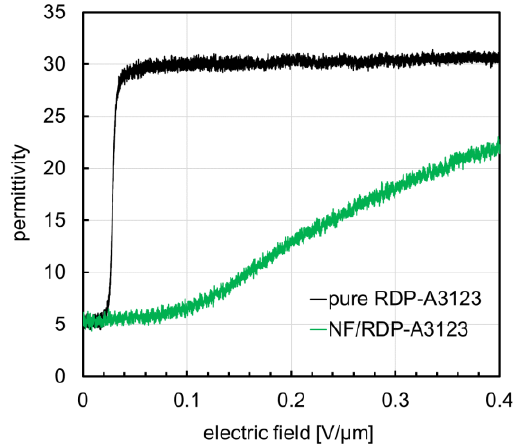
Figure 10. Electric field dependencies of ( a ) phase change, ( b ) rise time, and ( c ) decay time in NF/RDP-A3123 complex and pure RDP-A3123.